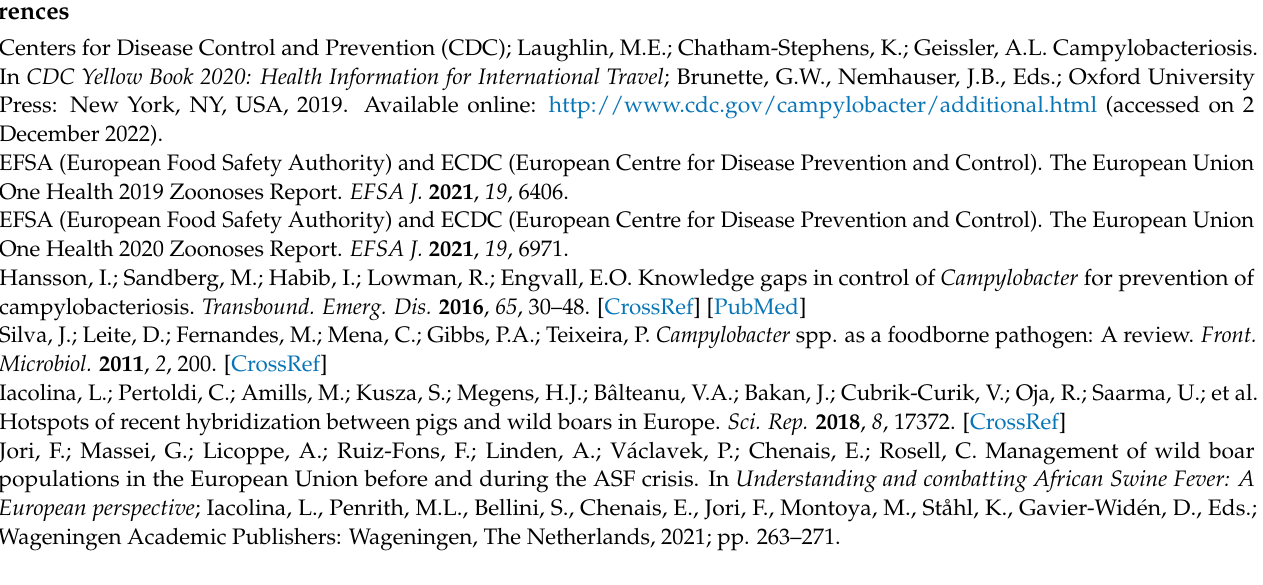
Figure S3: Characteristic spectra of Campylobacter jejuni isolates ( n = 2) generated by the Bruker Ultraflextreme MALDI TOF system. The intensities and m/z of the ions are shown on the Y- and X-axes, respectively. Sample codes (in accordance with those in Table 3) are displayed on the right at the end of each